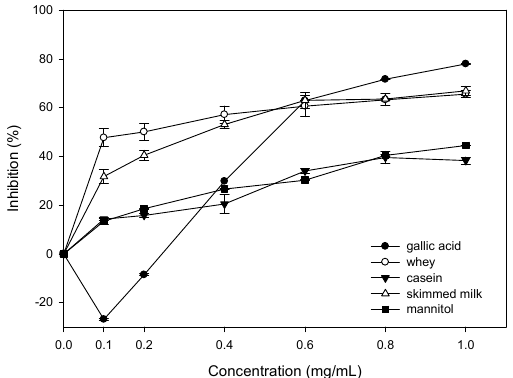
Figure 1. Effect of whey, casein and skimmed milk on the Fe 2+ -ethylenediaminetetraacetic acid (EDTA)/H 2 O 2 /Asc induced oxidative damage of deoxyribose.